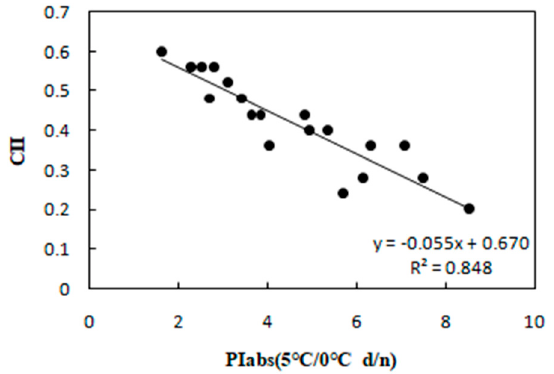
Figure 7. Correlation between PIabs and CII in 20 wucai genotypes measured in 5/0 °C (d/n) treatment.